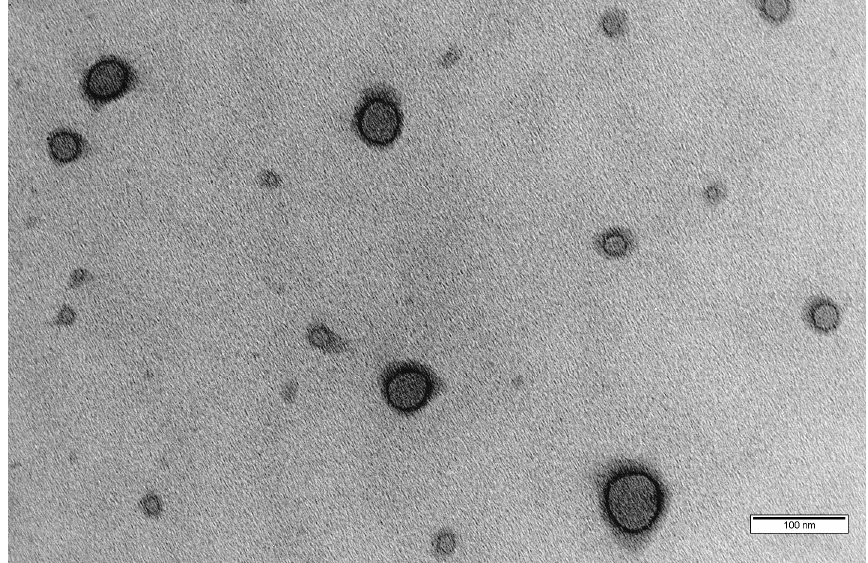
Figure 6. Unstained TEM image of drug-loaded (5 wt.% Dox·HCl) polymersomes (scale bar = 100 nm).